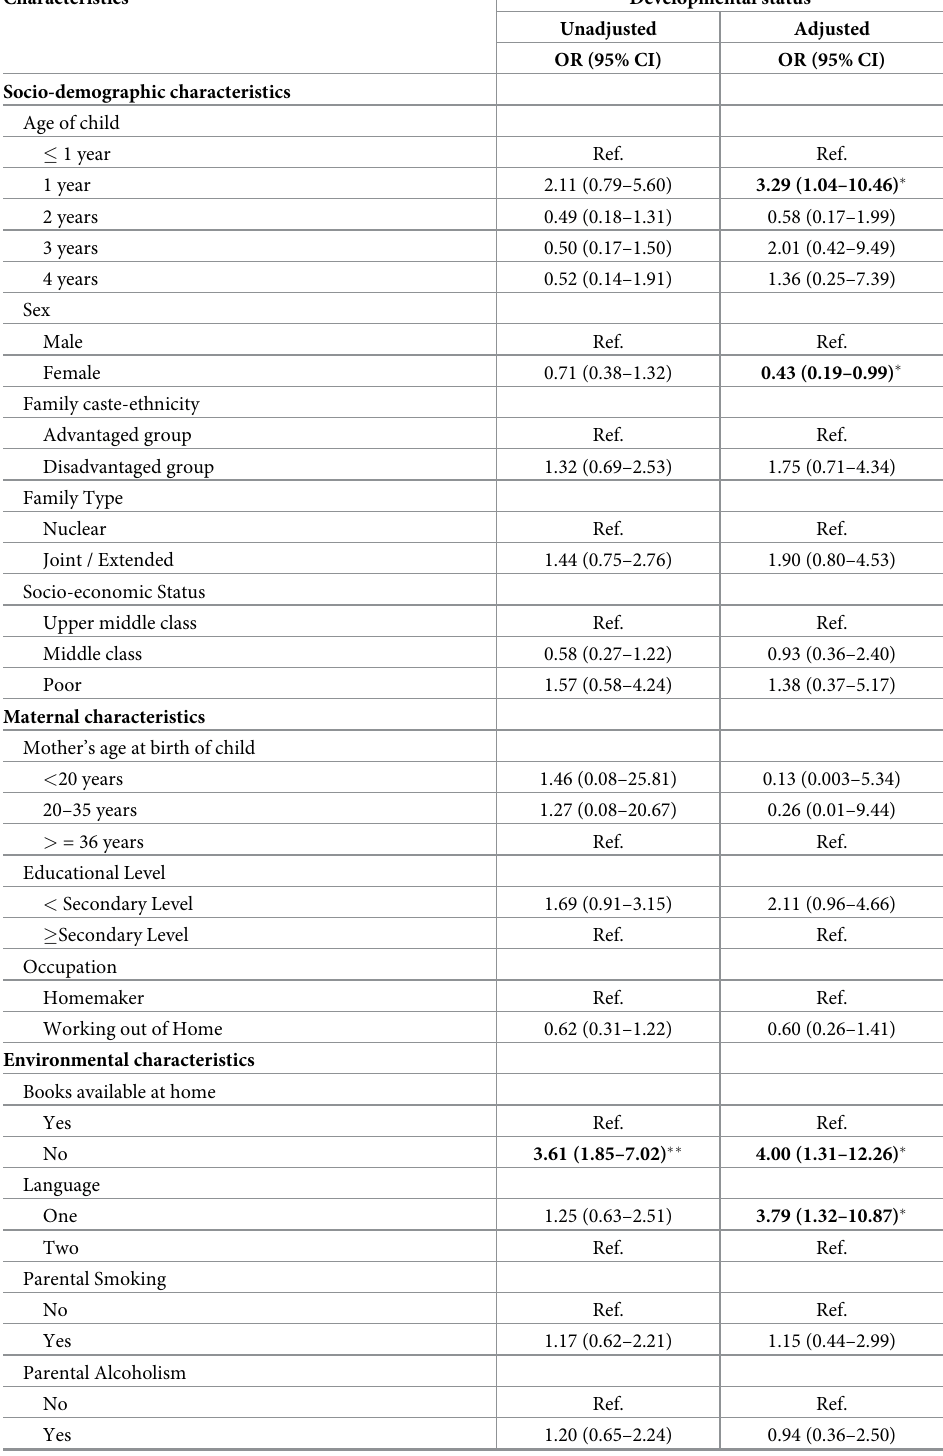
Table 6. Factors associated with developmental status of children (n =